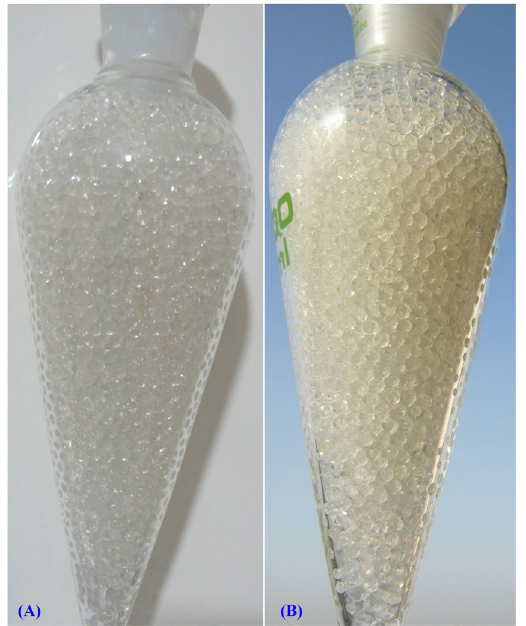
Figure 9. Immobilization of Azotobacter nigricans NEWG-1in alginate beads during Cu 2 + ions removal from aqueous solution. ( A ) Separating funnel packed with alginate beads, ( B ) Separating funnel packed with alginate- Azotobacter nigricans NEWG-1 beads.